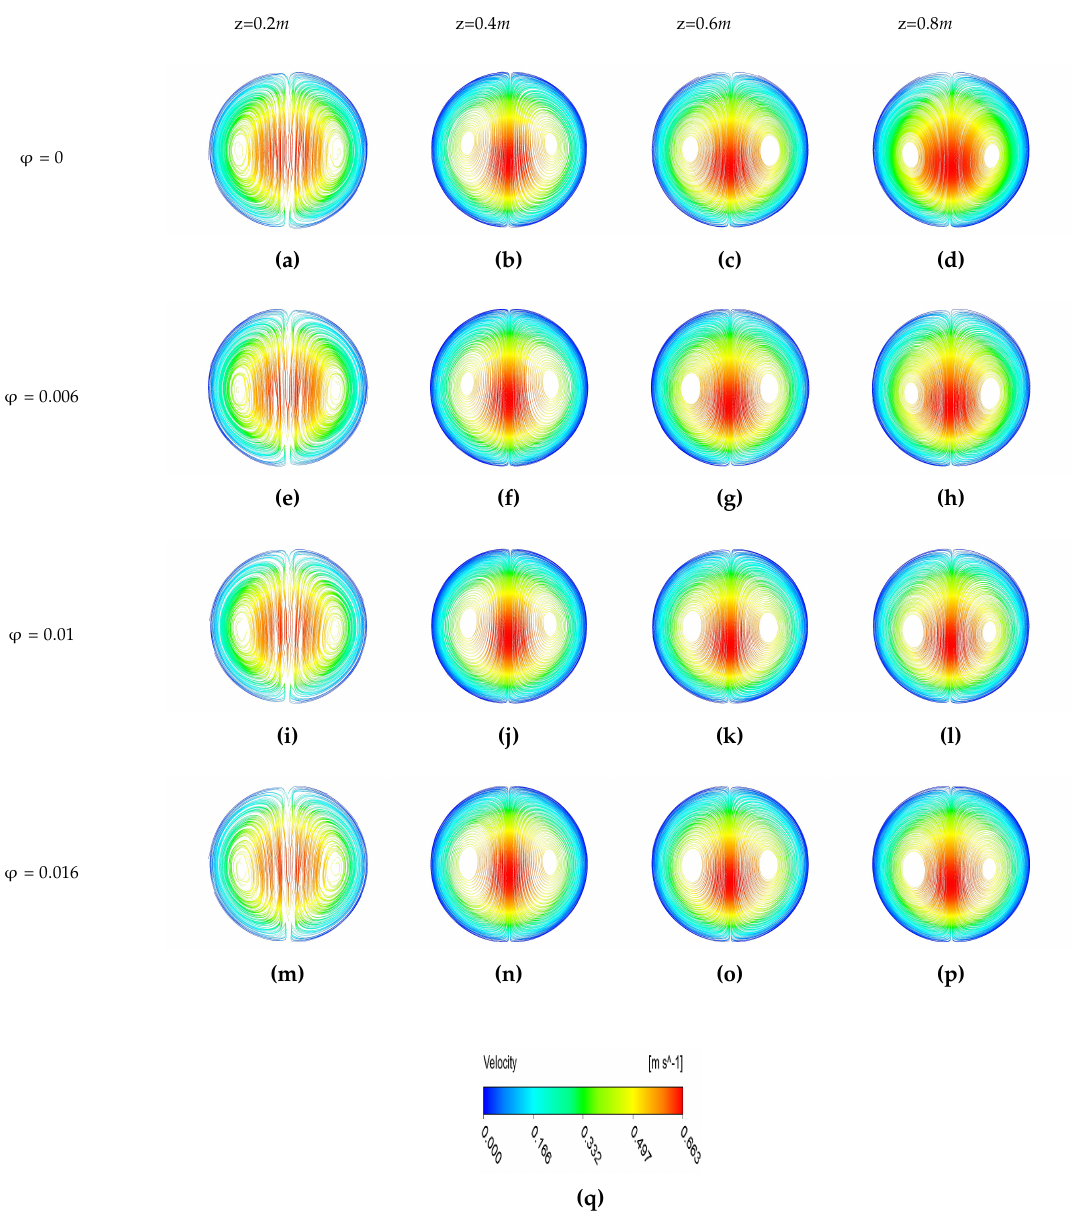
Figure 10. Streamline patterns colored by the axial velocity component w at four axial positions: z = 0.2 m ( a , e , i , m ); z = 0.4 m ( b , f , j , n ); z = 0.6 m ( c , g , k , o ); and z = 0.8 m ( d , h , l , p ). Results obtained for d np = 42 nm, Re = 1600 and four concentrations of Al 2 O 3 nanoparticles: ϕ = 0 ( a – d ); 0.006 ( e – h ); 0.01 ( i – l ); and 0.016 ( m – p